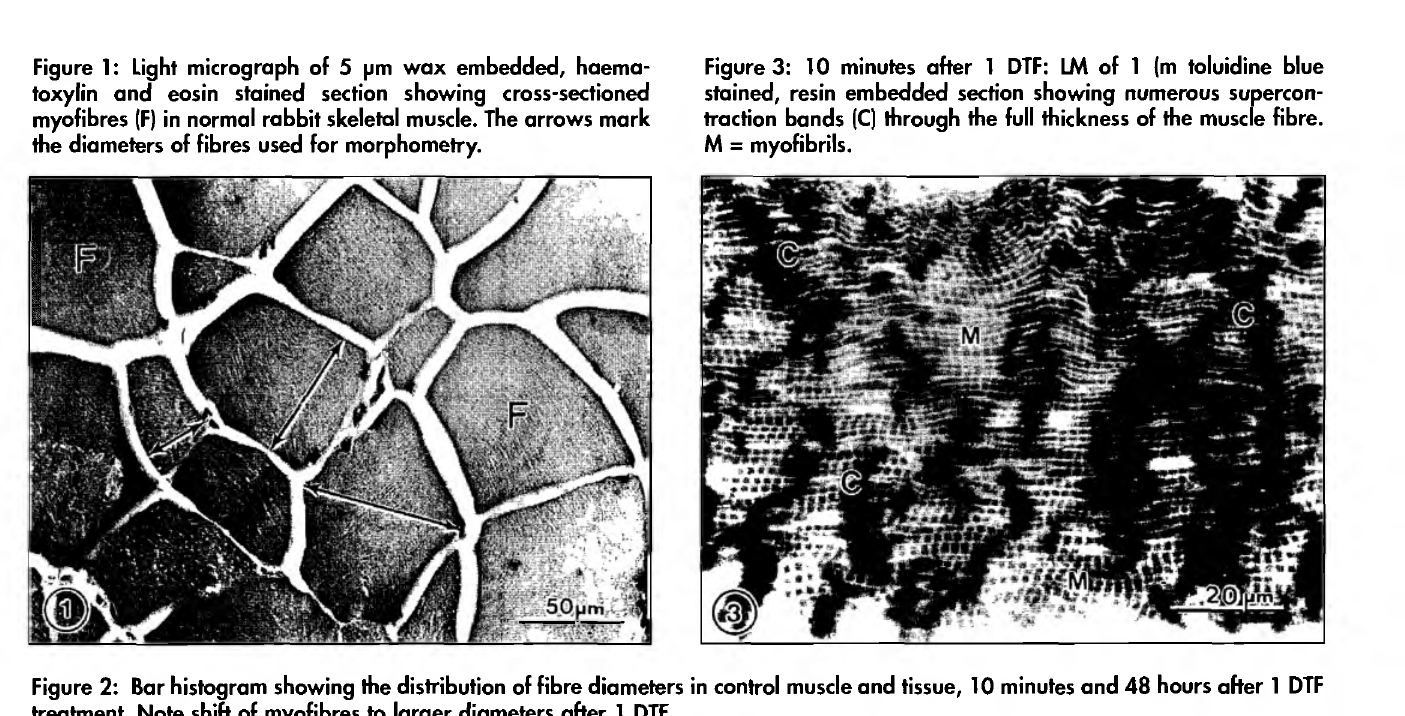
Figure 3: 10 minutes after 1 DTF: LM of 1 (m toluidine blue stained, resin embedded section showing numerous supercon­ traction bands (C) through the full thickness of the muscle fibre. M = myofibrils.